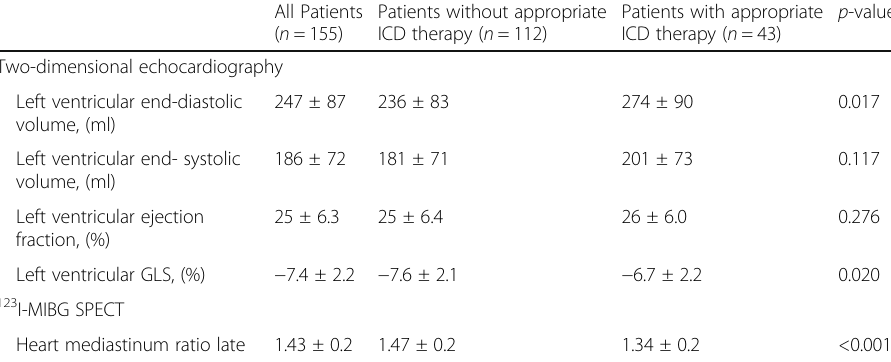
Table 2 LV GLS and 123 I-MIBG characteristics